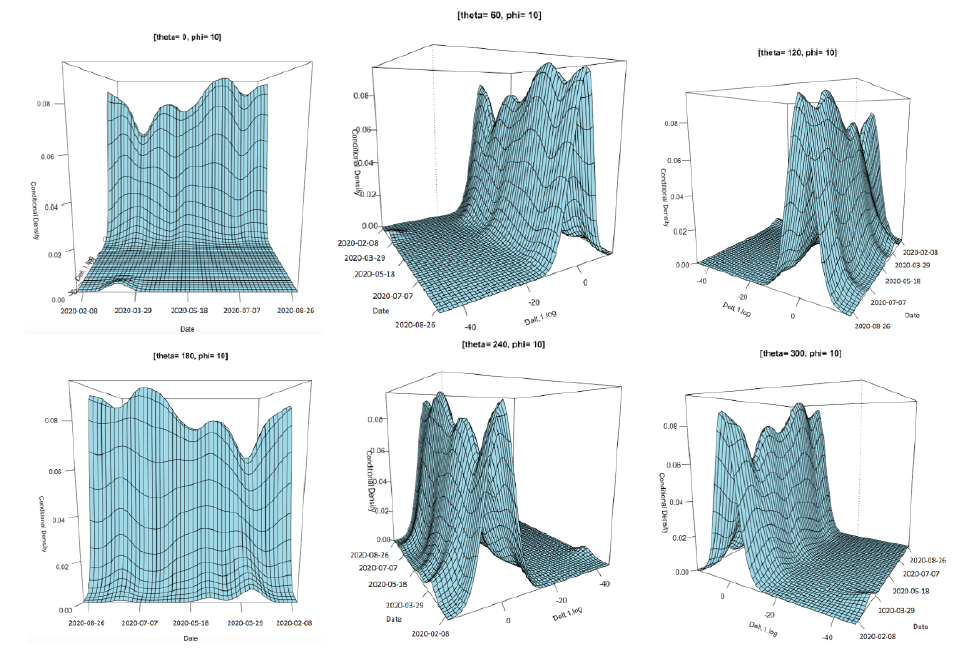
Figure 5. Density of Bitcoin: COVID